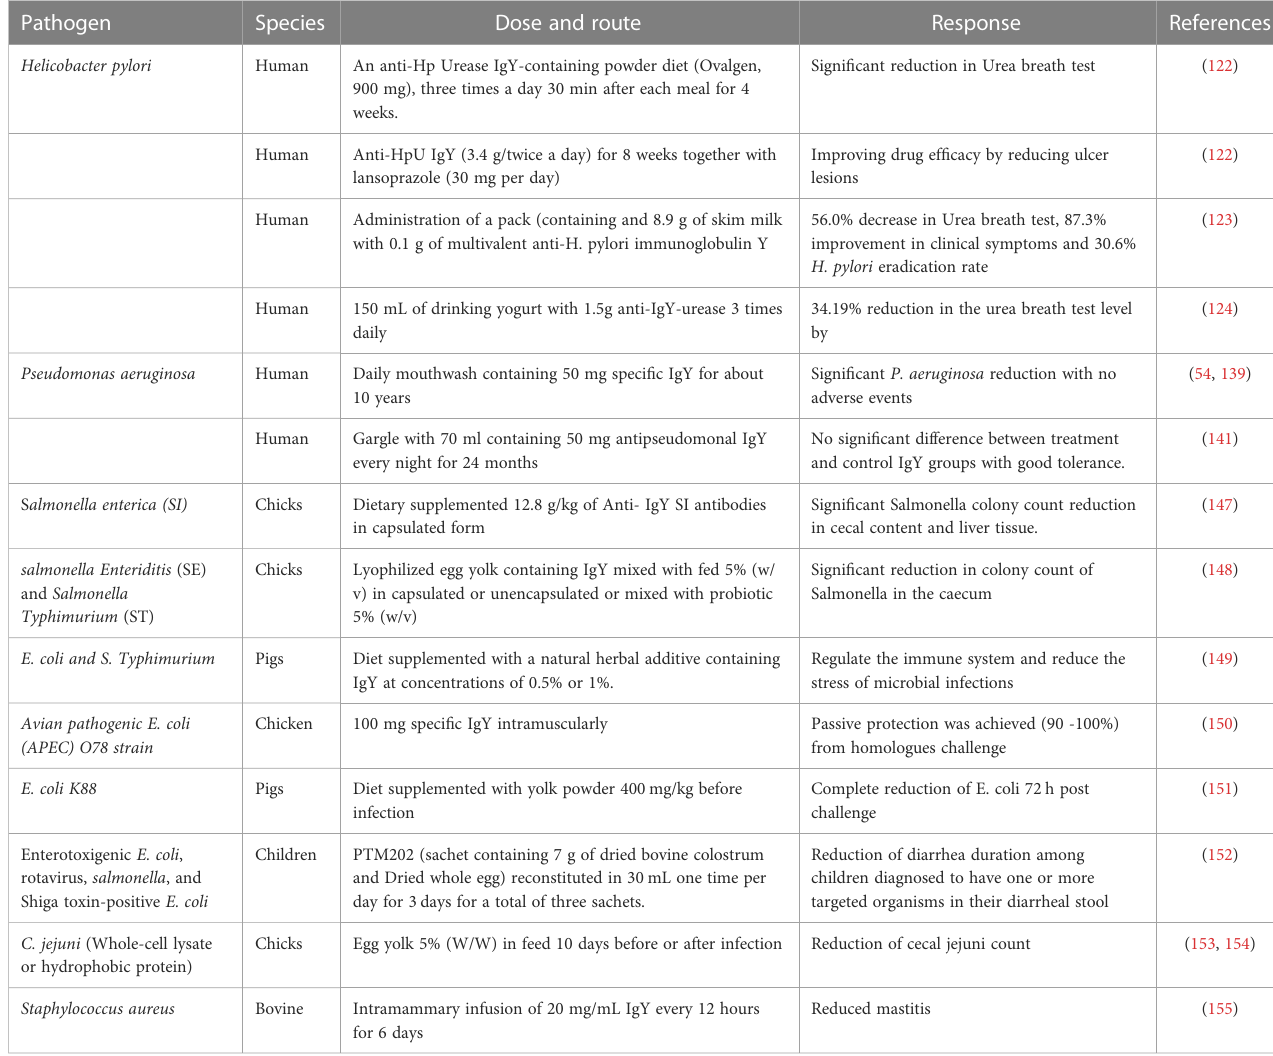
TABLE 1 Assessment of the ef fi cacy of speci fi c IgY antibodies against AMR for humans and animals.